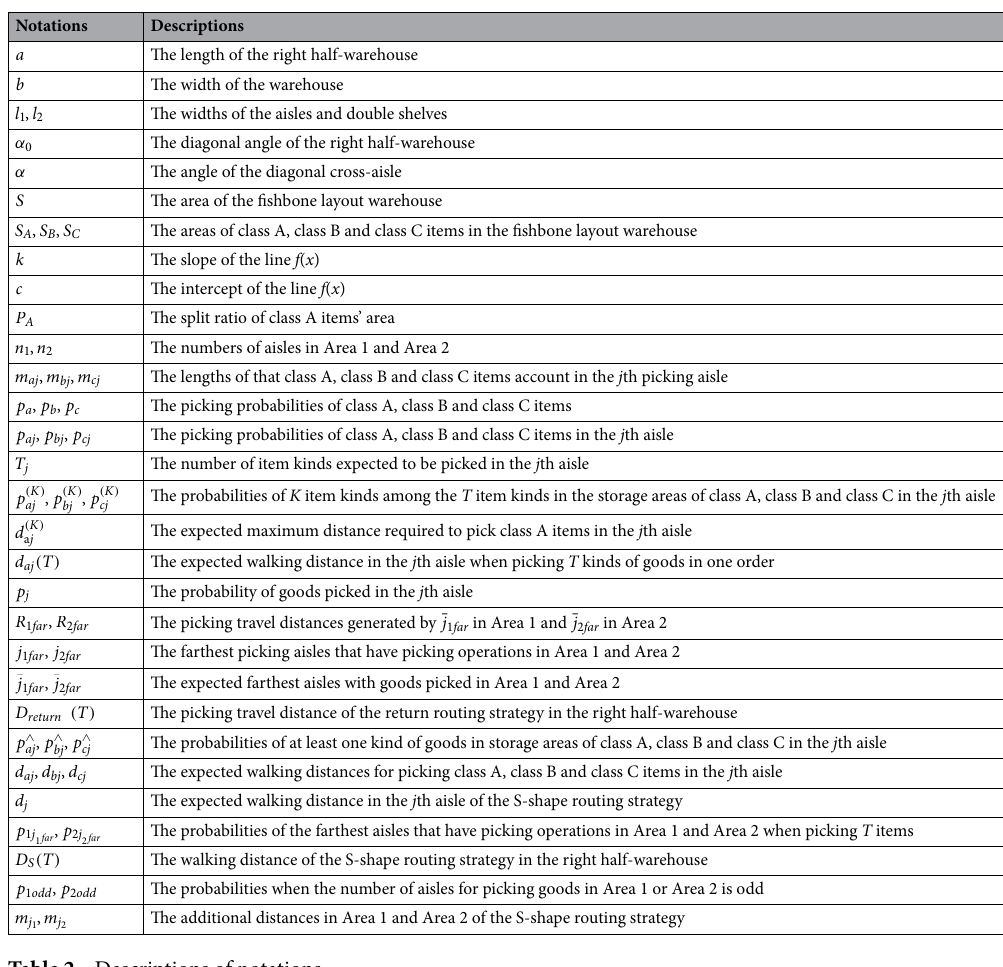
Table 2. Descriptions of